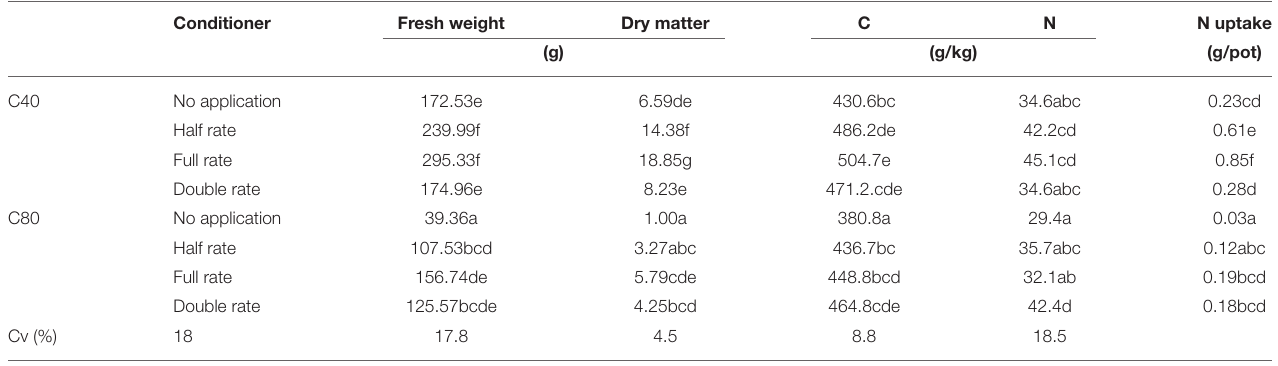
TABLE 5 | Interactive effect of compost and Bioplant on yield, nutrient composition, and N uptake of lettuce. Conditioner